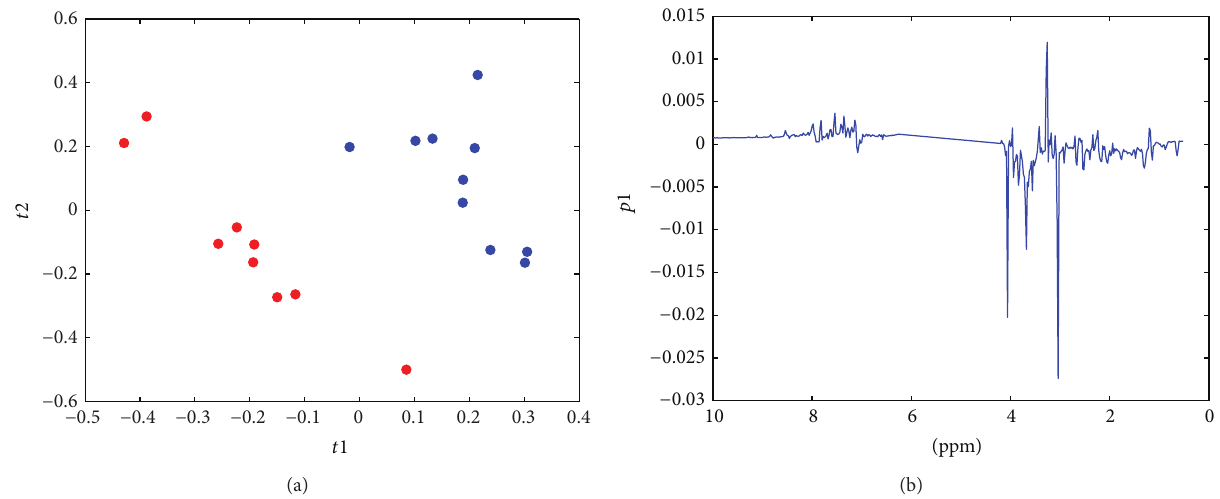
Figure 4: (a) Score plot of PLS model based on NMR data from first two stages (red dots represent samples from stage I; blue dots represent samples from stage II). (b) PLS loading plot. Positive value corresponds to metabolites at higher concentration in the urine sample of stage I and vice versa.